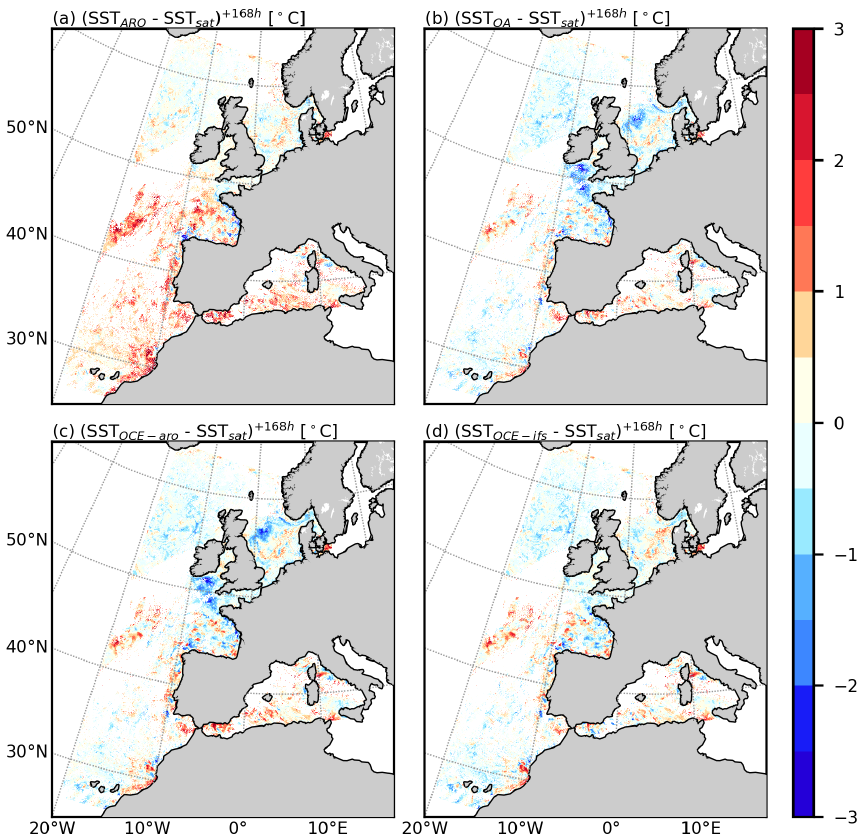
Figure 4. Comparison with L3 satellite SST observations at the end of the simulation (19 October 2018, 00:00UTC) : differences ( ◦ C)